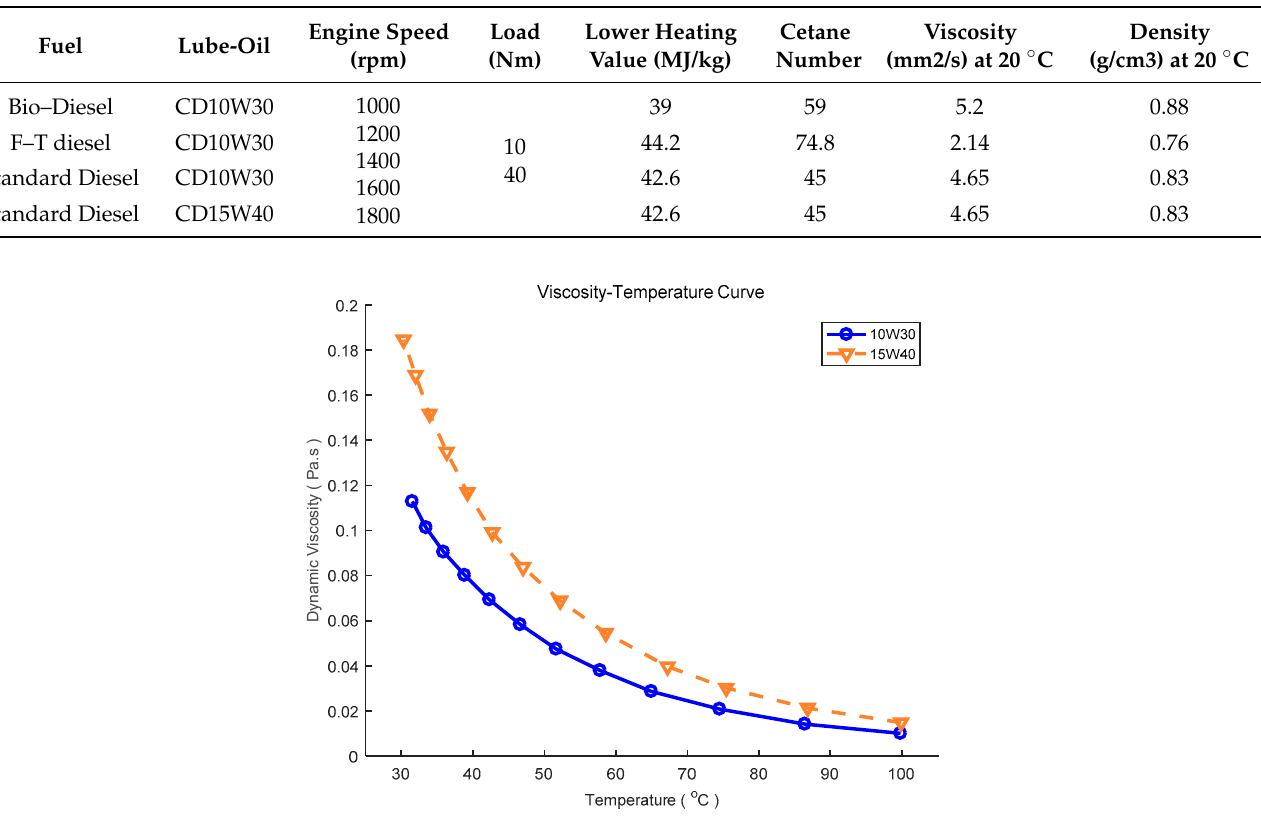
Table 2. Engine operating conditions and the fuels properties tested.